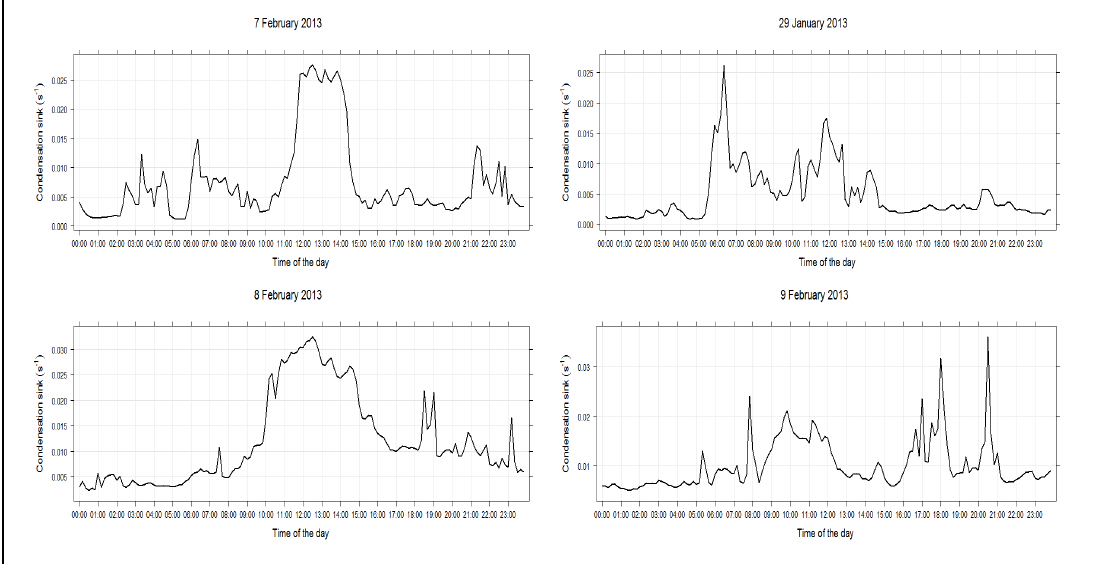
Figure A2. Time series of the condensation sink on the Class I (22 January, 6 February 2013, 7 February 2013 and 8 February 2013) and Class II event days (17 January, 27 January 2013 and 29 January 2013 and 9 February